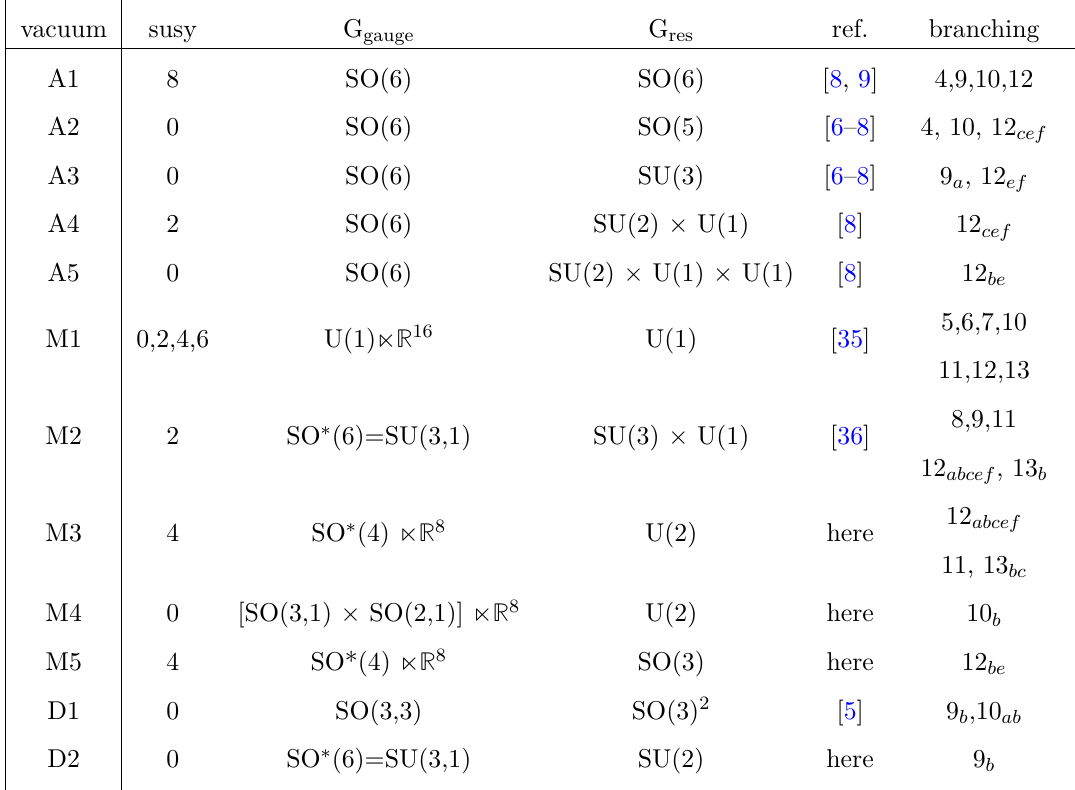
Table 7 . Summary of vacua found in this